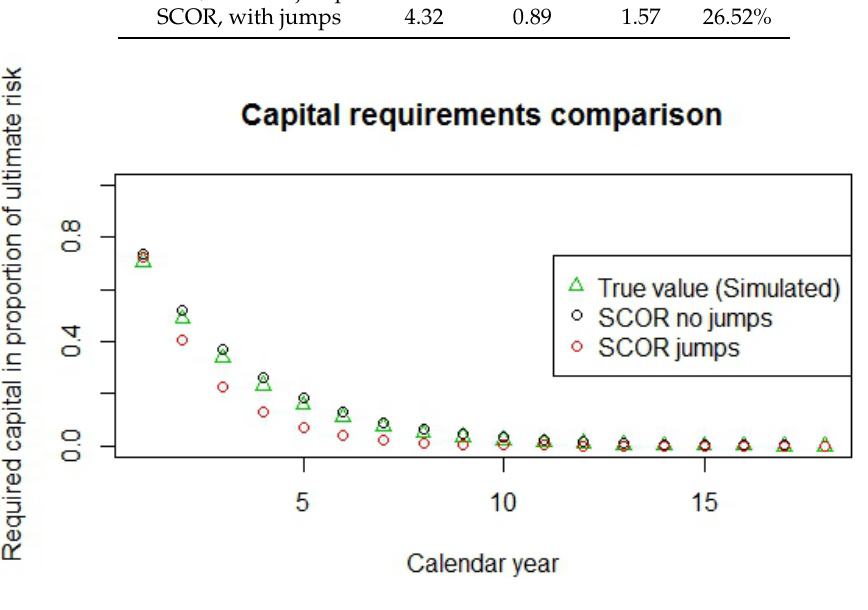
Figure 4. Comparison of the average yearly required capital over 500 triangles as proportion of the